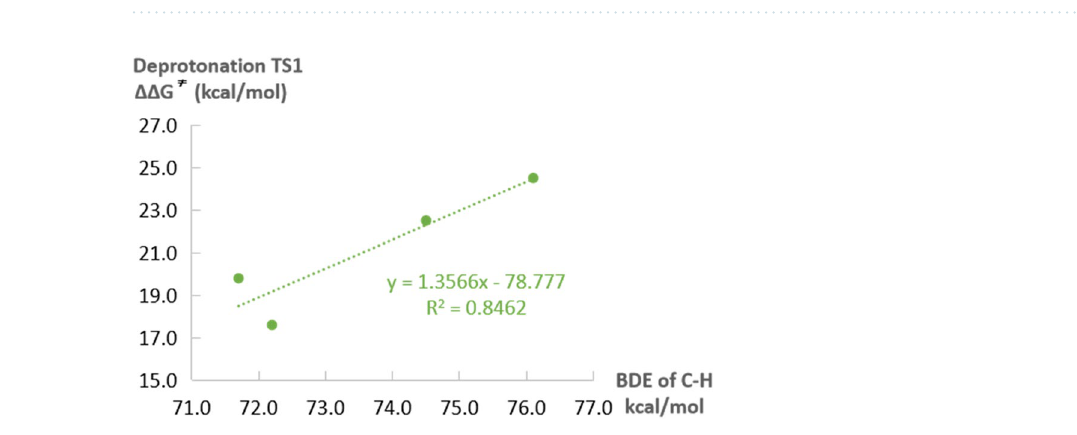
Table 1. The reaction yields and the calculated energy barriers of deprotonation transition states for different substrates.